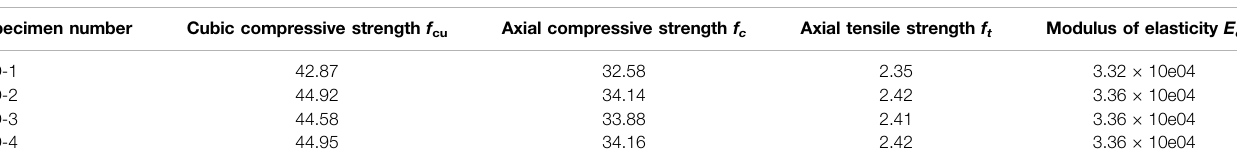
TABLE 2 | Mechanical properties of concrete (N/mm 2